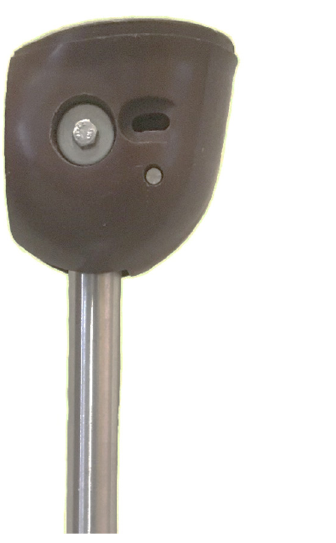
Figure 1. Left: ICRC knee joint; Right: All-Terrain knee joint.